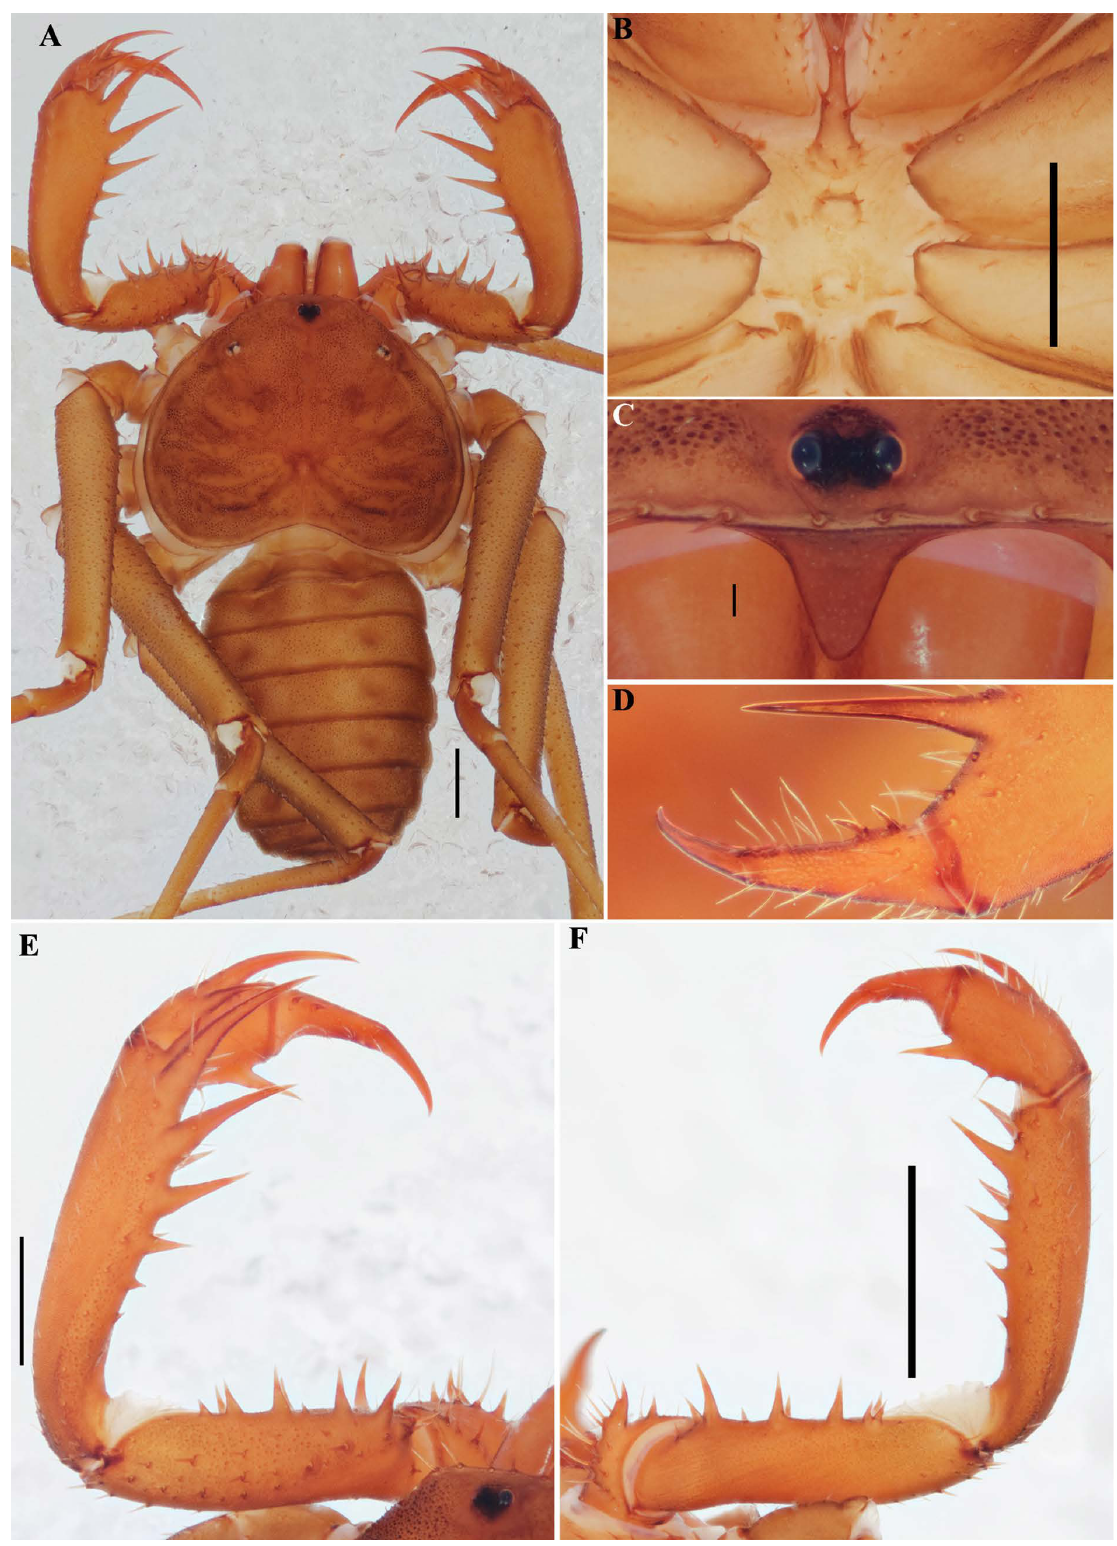
Fig. 76. Charinus souzai sp. nov. (MNRJ 9090), general morphology, ♀. A . Habitus, dorsal view. B . Sternum, ventral view. C . Frontal process. D . Pedipalp tarsus, frontal view. E . Pedipalp, dorsal view. F . Pedipalp, ventral view. Scale bars: A–B, E–F = 1 mm; C = 0.1 mm; D = 0.5